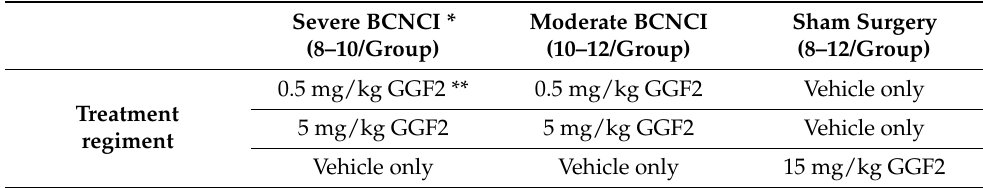
Table 1. Distribution of CN lesion rat model population, according to CN injury protocol and treatment applied, as reported by Burnett et al.